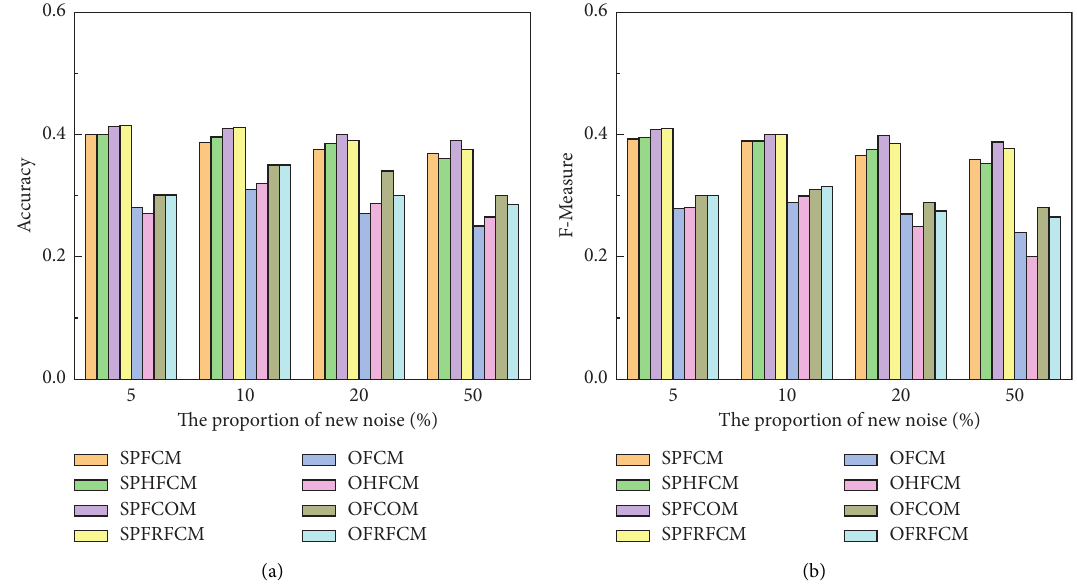
Figure 8: Robustness comparison on the GS dataset. (a) Accuracy; (b)